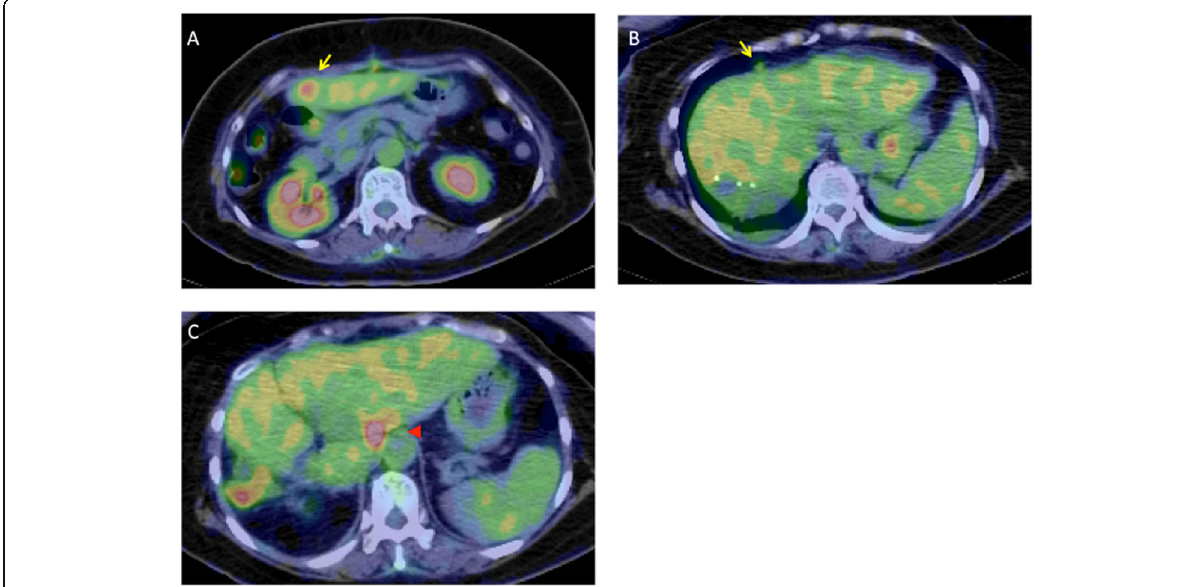
Fig. 5 Positron emission tomography (PET) findings on POW 7. a PET showing intrahepatic recurrence (arrow). b PET showing peritoneal dissemination (arrow). c PET showing hilar lymph node metastasis